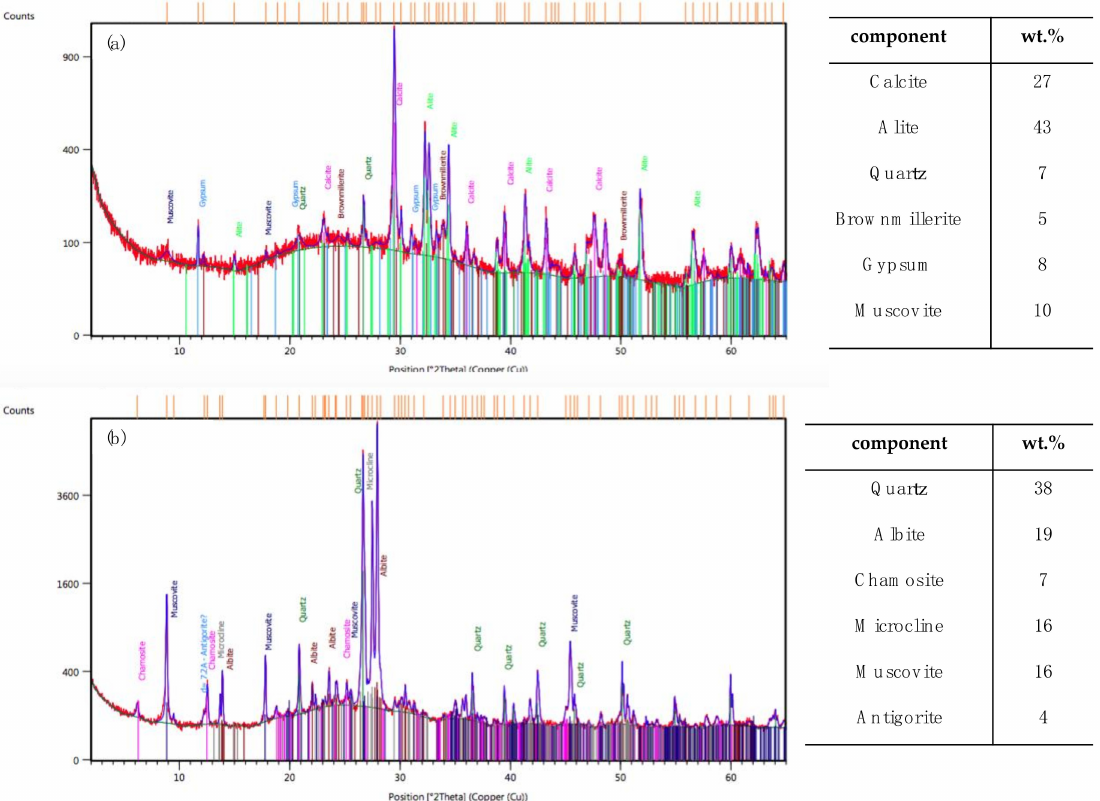
Figure 4. Mineralogical composition of concrete specimens revealed by X-ray diffraction (XRD) analysis: ( a ) Cementitious part, ( b ) sandy